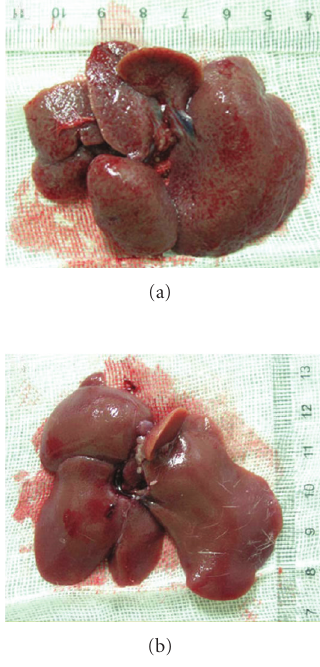
Figure 1: Observation of the appearance of rat liver. Severity of the cirrhosis of rats in the model (a) control group was much worse than that in (b) the group treated with high dose of